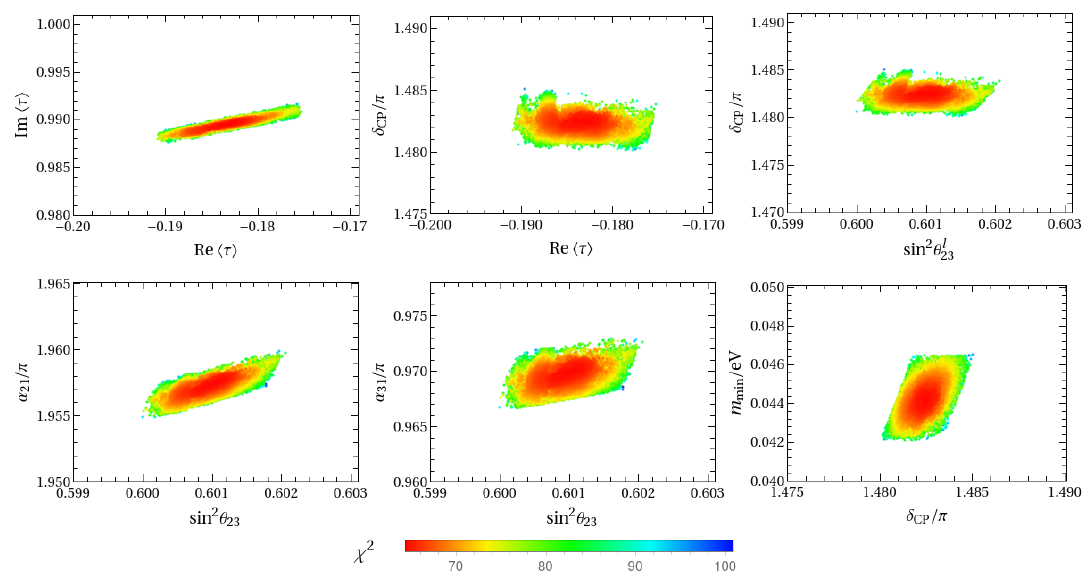
Figure 1. Results of the parameter-space scanning for the benchmark model of neutrino masses generated by the Weinberg operator. The T 0 representation and modular-weight assignments are given in (6.10). We present the scatter plots in distinct bidimensional planes of the neutrino mixing angles, CP phases and the real/imaginary part of h τ i . The colour grading reflects the values of the χ 2 for each point, according to the scale shown at the bottom of the